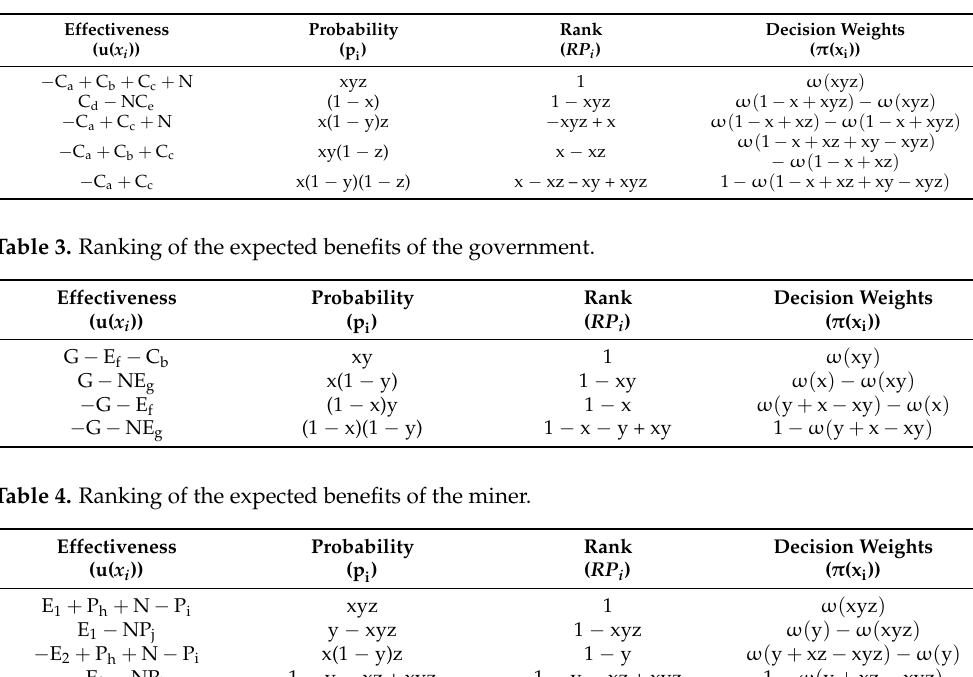
Table 2. Ranking of the expected benefits of the SMEE.